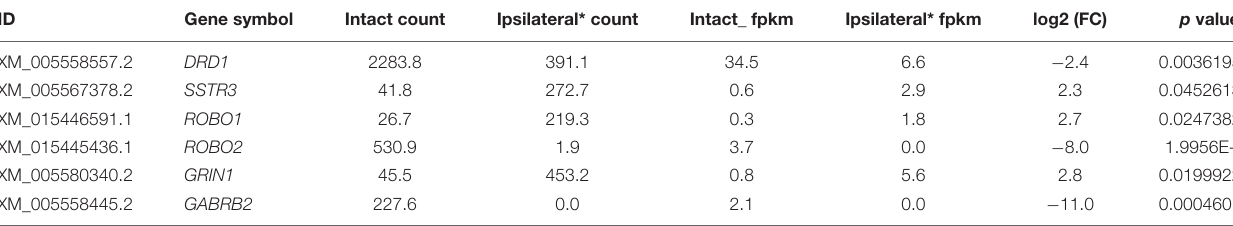
TABLE 3 | Receptors selected for verification that were associated with neural